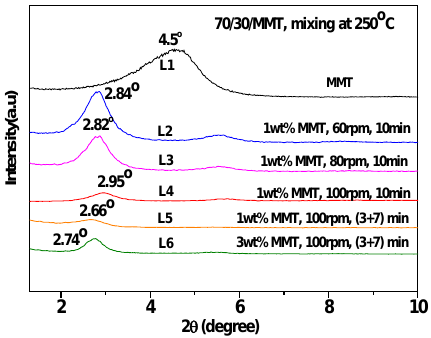
Figure 5. The WAXD patterns of MMT (Cloisite ® 25A) in the 70/30 PTT/PC blends processed at 250 °C with indicated shear and processing mode.